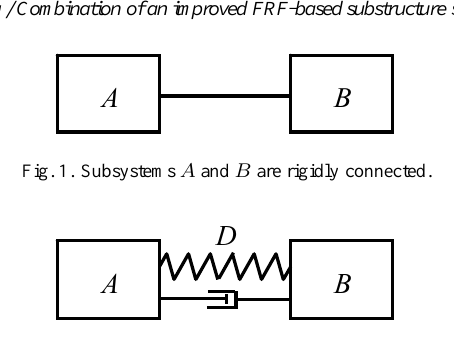
Fig. 2. Subsystems A and B are connected by a number of dampers (springs and